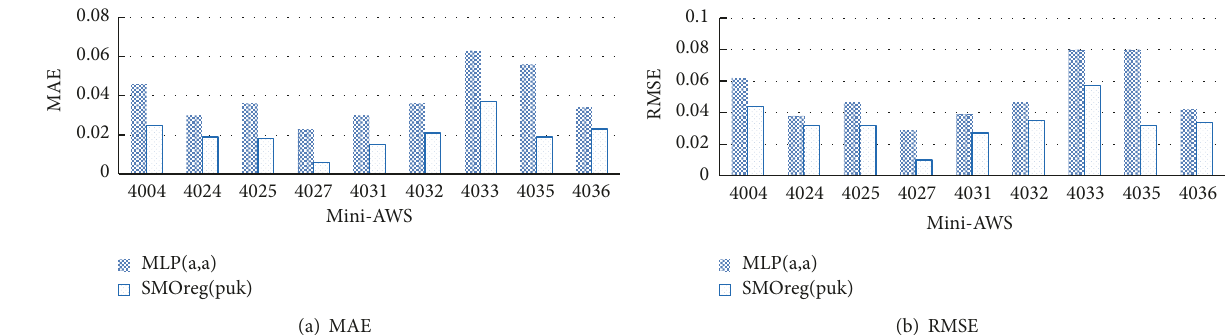
Figure 8: Experimental results for MLP (option a,a ) and SMOreg (option puk